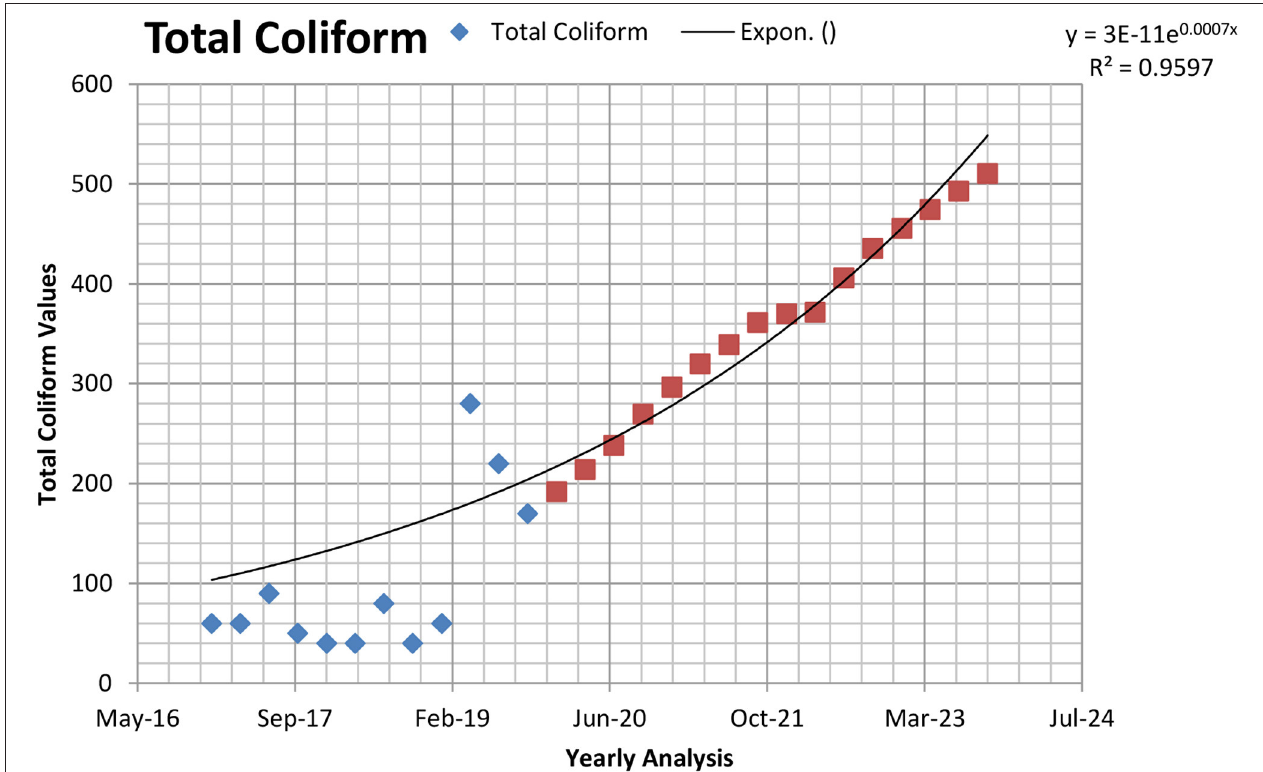
FIGURE 10 | Trend forecasting of total Coliform at Dehradun for the years from 2020 to 2024.